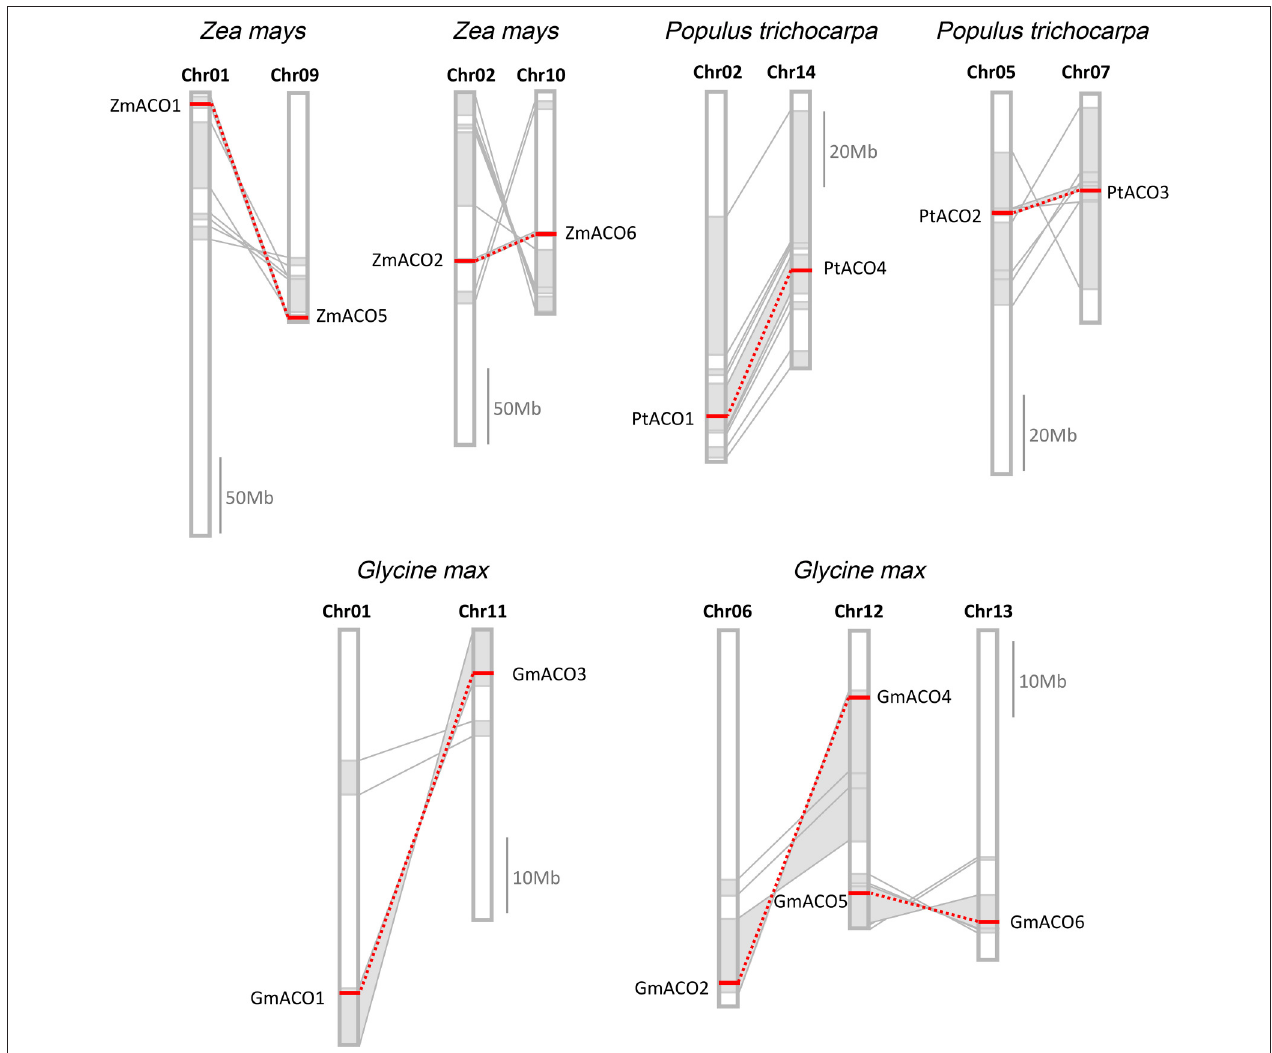
FIGURE 6 | Duplicate gene pairs created by segmental duplication in Z. mays , P. trichocarpa, and G. max . Homologous genome blocks are shaded with gray and connected with lines. Duplicate gene pairs are connected with red dotted